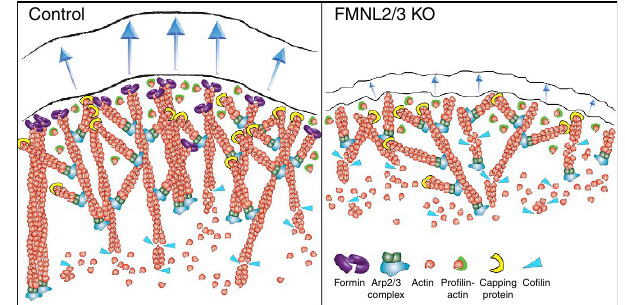
Figure 8 | Model summarizing FMNL2/3 loss of function phenotype. Lamellipodial actin filament networks are generated and turned over by combined activities of filament assembly factors (Arp2/3 complex and formins), disassembly factors such as cofilin and by capping protein. As opposed to the branching activity of Arp2/3 complex, lamellipodial formins FMNL2 and FMNL3 are not essential for the generation of lamellipodial actin networks, but proposed to generate specific subsets of filaments contributing to the density and mechanical stability of lamellipodia, essential for effective protrusion and lamellipodial force generation ( FMNL2/3 KO) during